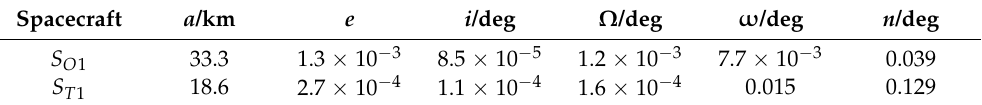
Table 2. Initial deviations of orbital elements.